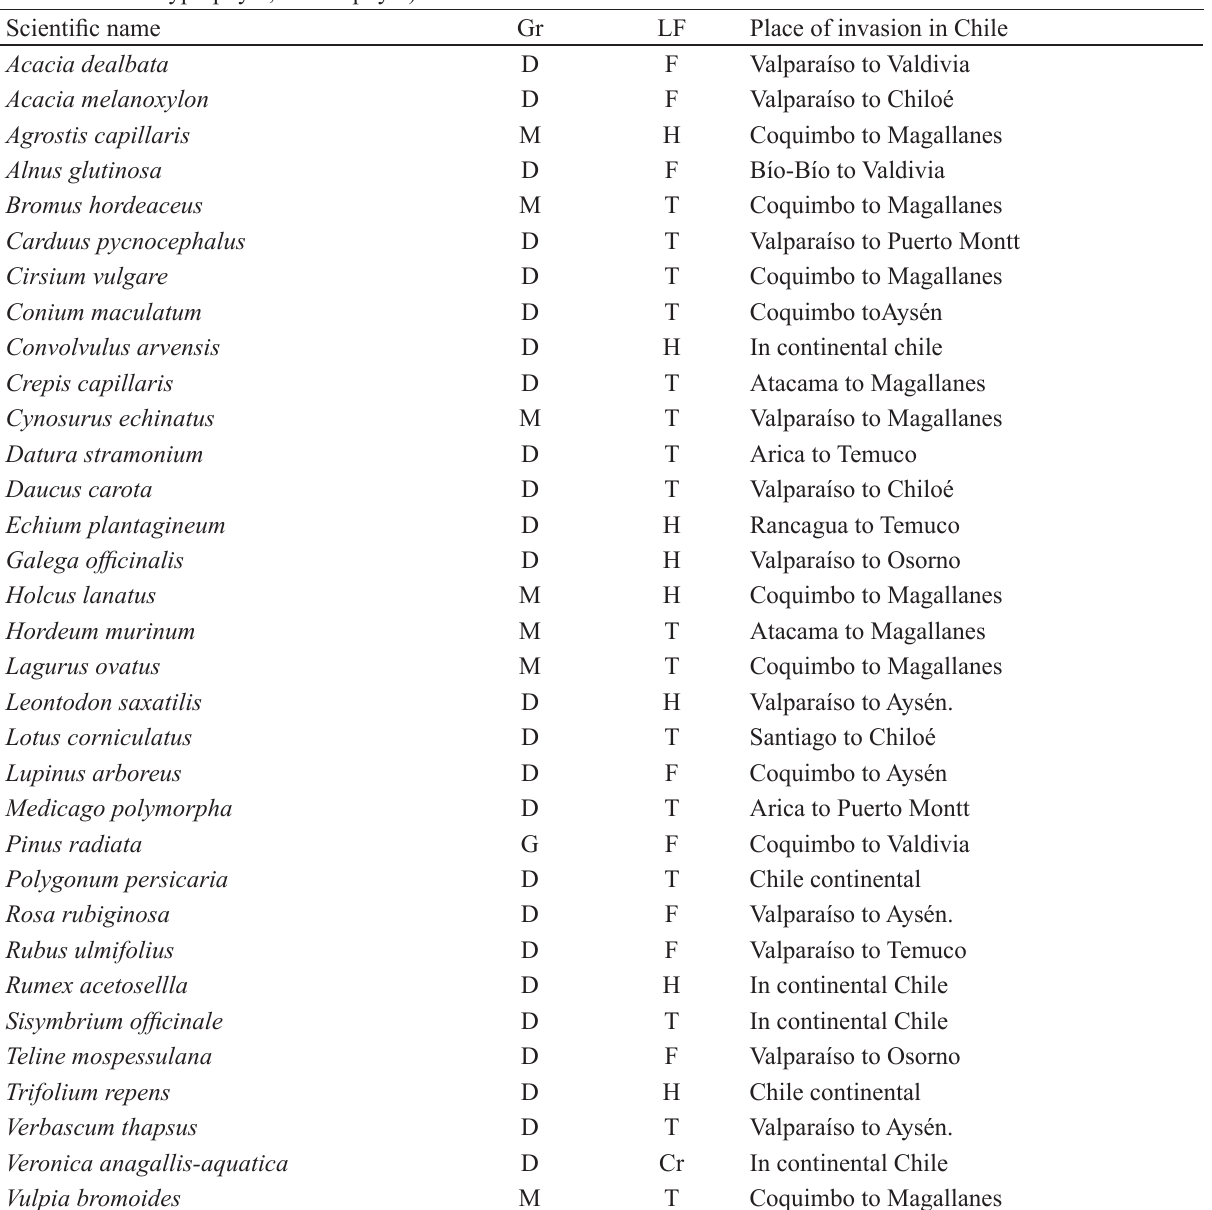
Table 6. Invasive plant species determined in the work place. It indicates Scientific name, classification, life forms and presence in Chile. Abbreviations: Gr: Classification group (D: Dicotyledon, M: Monocotyledon, G: Gymnosperm, H: Fern); LF: Life form (F: Fanerophyte, C: Chamaephyte, H: Hemicryptophyte, Cr:= Cryptophyte, T: Terophyte).